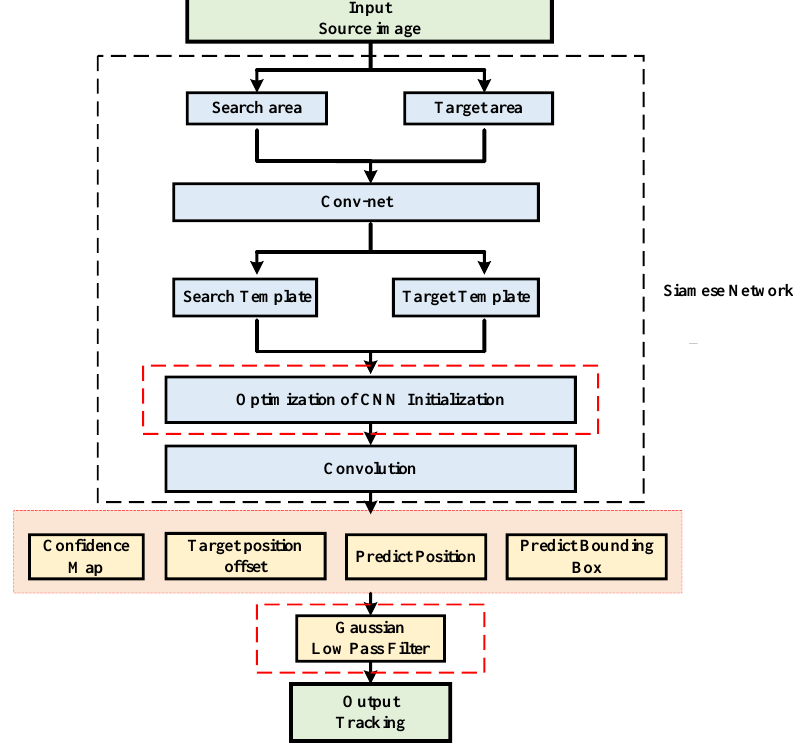
Figure 3. Scheme and sequence of the overall research